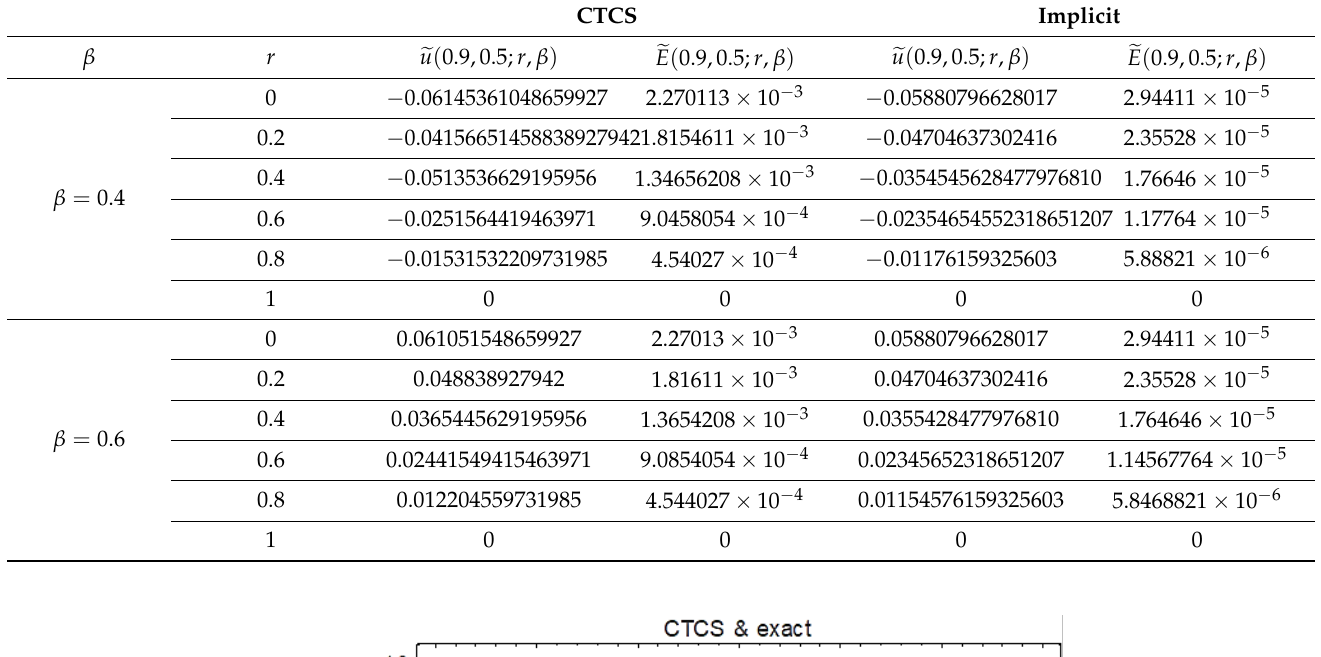
Table 4. Numerical solution of Equation (33) by CTCS and implicit at t = 0.05 and x = 0.9 for r , β ∈ [ 0,1 ] .